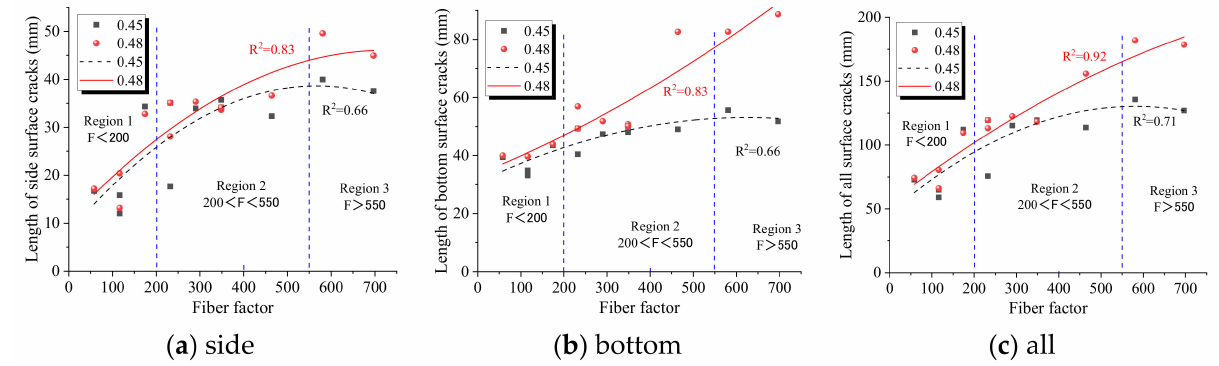
Figure 8. Relationship between fiber factor and crack